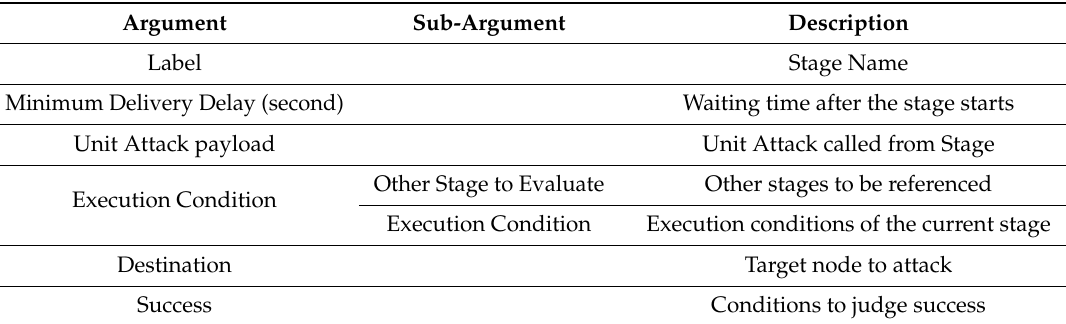
Figure 2. Hierarchical multi-stage cyber attack scenario modeling method. Table 2. Components of the stage.